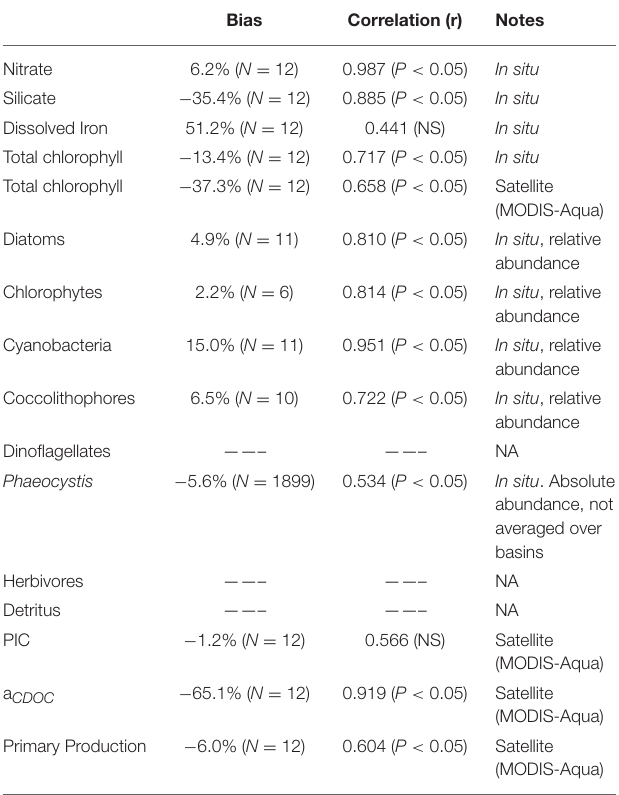
TABLE 1 | Bias and correlation of major model variables with data